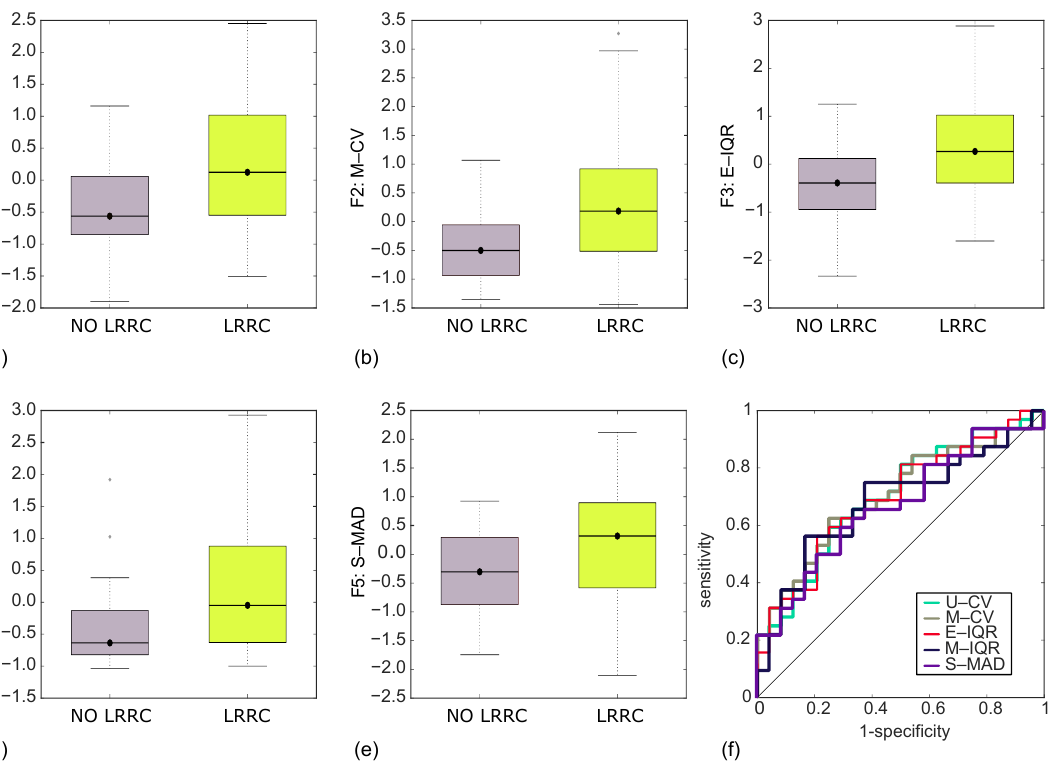
Figure 3. Boxplots of the discrimination achieved by PET/CT imaging, between NO LRRC and LRRC groups, through U-CV ( a ), M-CV ( b ), E-IQR ( c ), M-IQR ( d ), and S-MAD ( e ), and their ROC curve ( f ), yielding AUC = [0.67–0.70], SN = [56–63]%, SP = [71–79]%, and I =